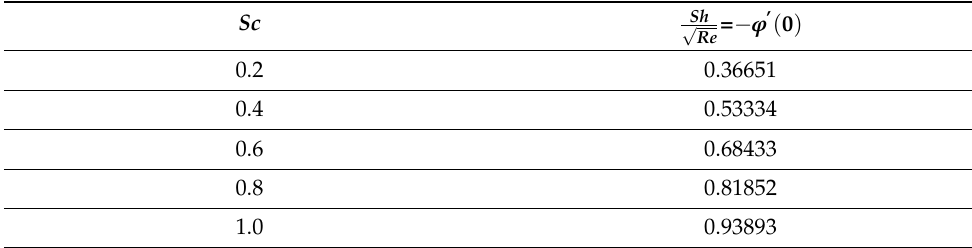
Table 3. Impact of Sc on the Sherwood number for We = 0.2; n = 2; Ec = 0.2; Pr = 0.7; λ = 0.1; Nr = 1; c = 5.